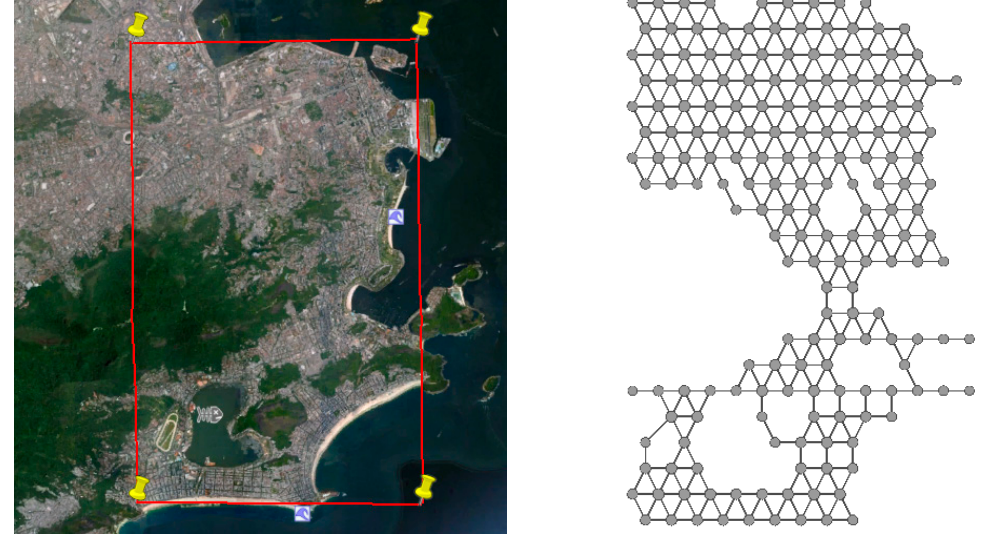
Figure 3. Area of interest in the city of Rio de Janeiro and its representation as a graph.